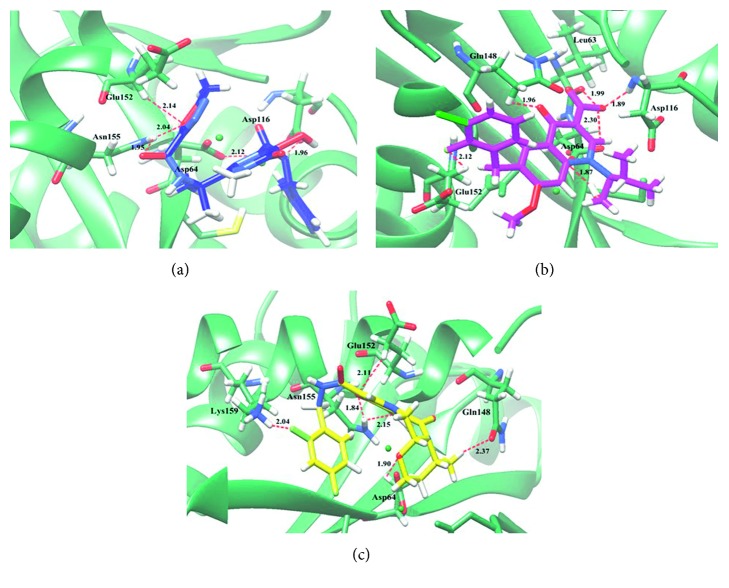
Molecular docking of HIV-1 IN inhibitors with HIV-1 IN. The ribbon model shows the backbone of the HIV-1 IN catalytic domain with all interacting amino acid residues shown as stick models and colored by heteroatoms. H-bond interactions are shown as red dashed lines and represent bond length in angstroms (Å). Mg2+ ions are shown as green balls. (a) Raltegravir, (b) elvitegravir, and (c) dolutegravir.